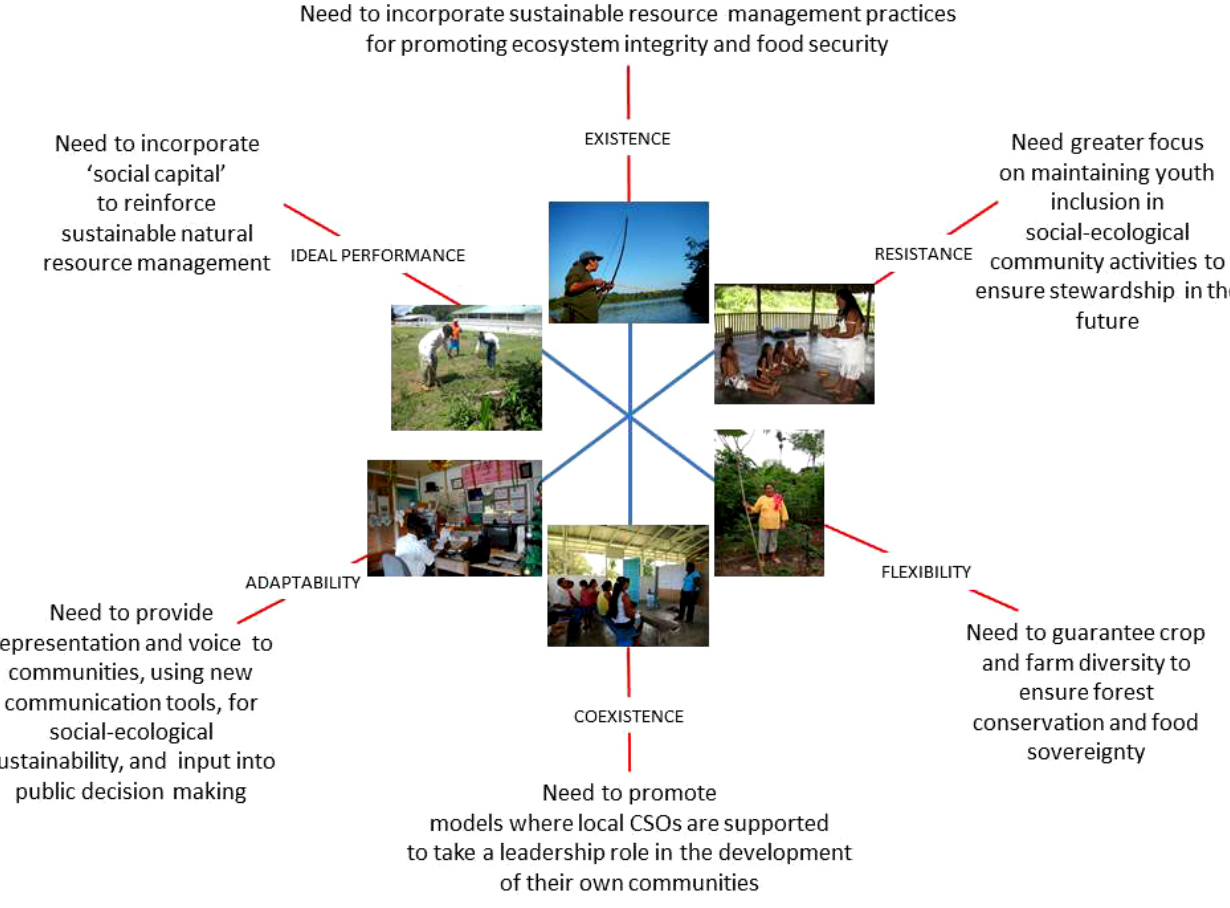
Fig. 9 . The six best practices from the North Rupununi, Guyana and their relevance at the national and international